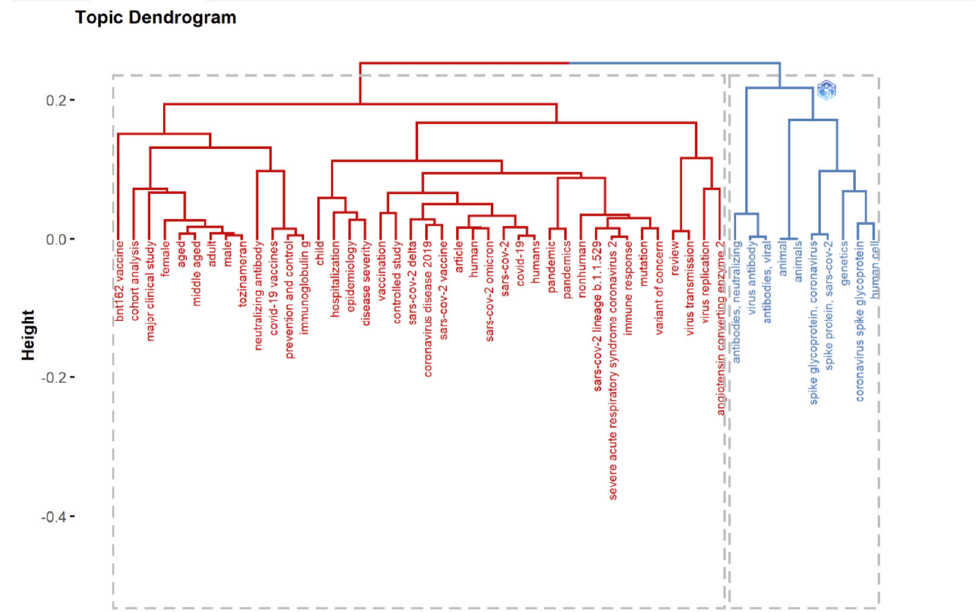
Figure 21. Topic dendrogram using multidimensional scaling that shows the hierarchical relationship between the topics in the identified field.